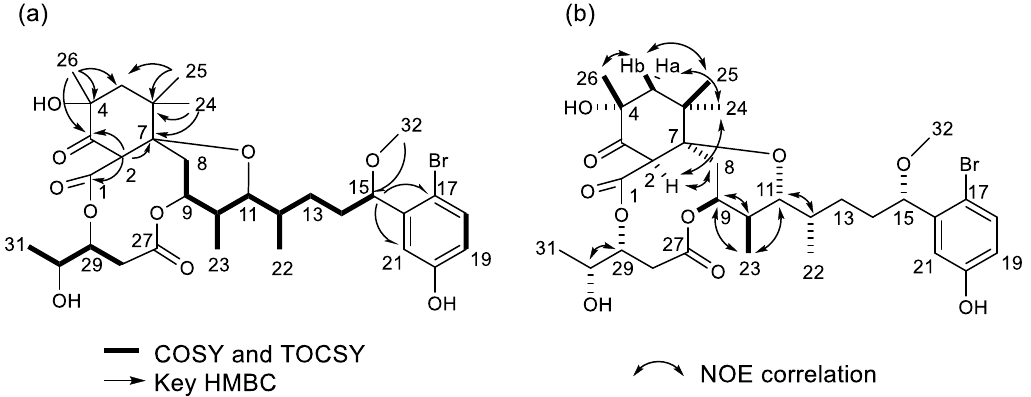
Figure 2. ( a ) Observed COSY, TOCSY, and HMBC correlations of 1 , ( b ) NOE correlations of 1 . Table 1. NMR data for neo-aplysiatoxin A ( 1 ) in methanol- d 4 (600 MHz for 1 H and 150 MHz for 13 C). No. δ H Multip. ( J in